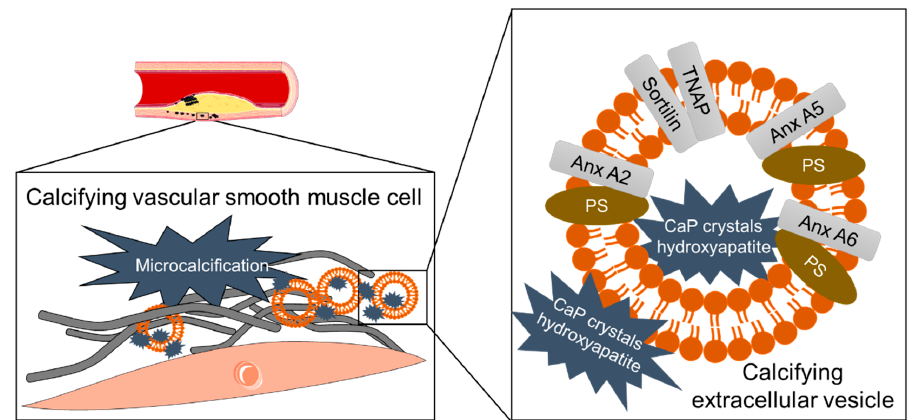
Figure 1. Calcifying extracellular vescilces trigger vascular microcalcification. Microcalcifications are formed within the vessel wall, triggered by released calcifying extracellular vesicles (EVs). These calcifying EVs have a characteristic proteomic and lipid composition. They can be carrier of calcium/phosphate crystals or hydroxyapatite. Anx: Annexin, CaP: Calciumphosphate, PS: Phosphatidylserine; TNAP: Tissue non-specific alkaline